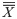
The VSI X¯ chart when m = 2.The VSI X¯ chart is illustrated when two sampling intervals are considered in a process. These sampling intervals are known as the short and long sampling intervals.